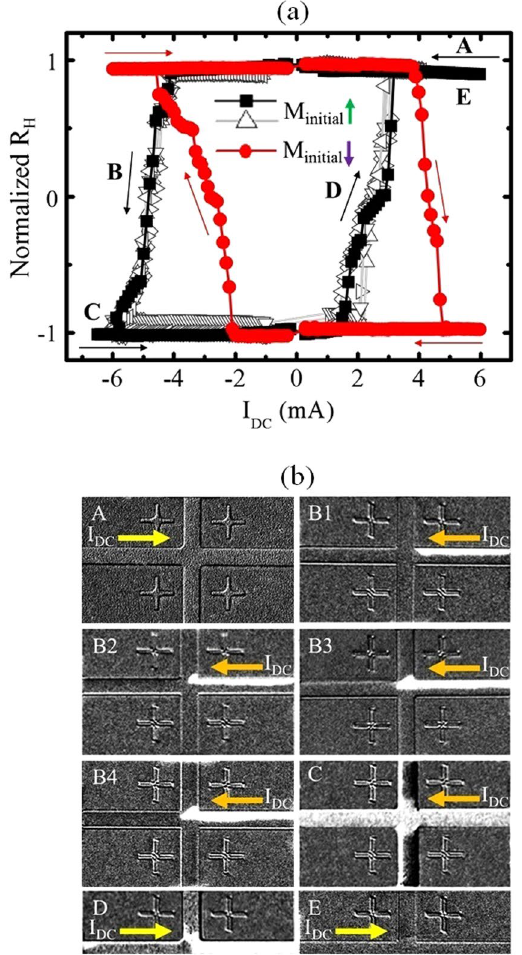
Figure 3. Field-free SOT-induced magnetization reversal process: ( a ) Measured R H as a function of DC current without external magnetic field for Pt/[Co/Ni] 2 /Co/Ta structure. ( b ) Kerr images at different stages during the reversal process. Image A shows the initial up ( + z ) state; images B1–B4 show the gradual reversal process from up to down ( − z ) state; image C shows that the magnetization has completely switched to the down state; image D shows the quasi stable state as the magnetization is reversed in the opposite direction; image E shows that the magnetization has switched back to the up state again. The yellow arrows show the corresponding current